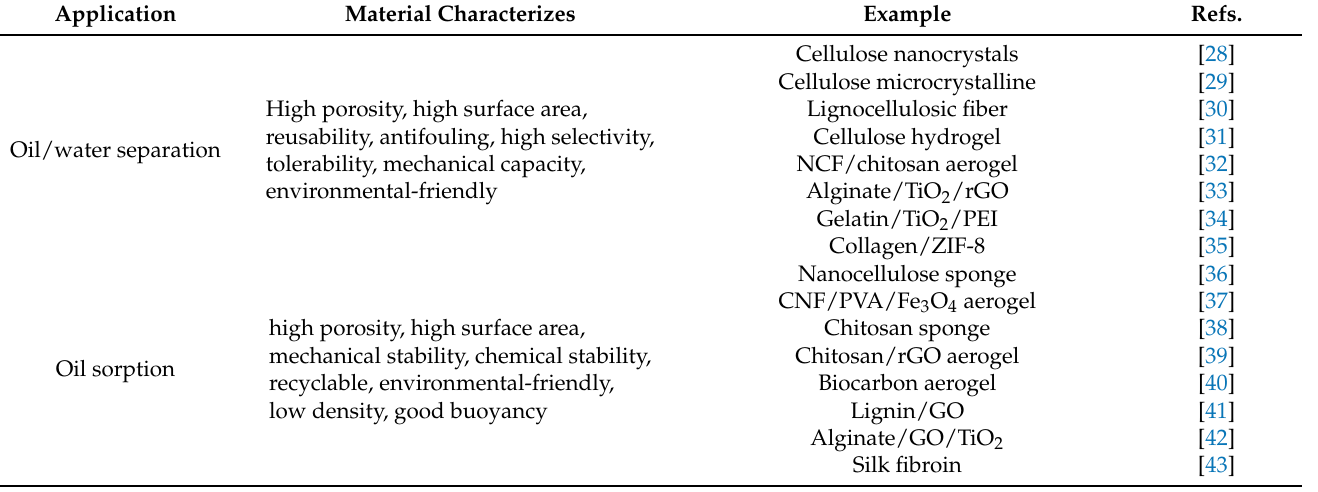
Table 3. Material characteristics and examples for oil/water separation and oil